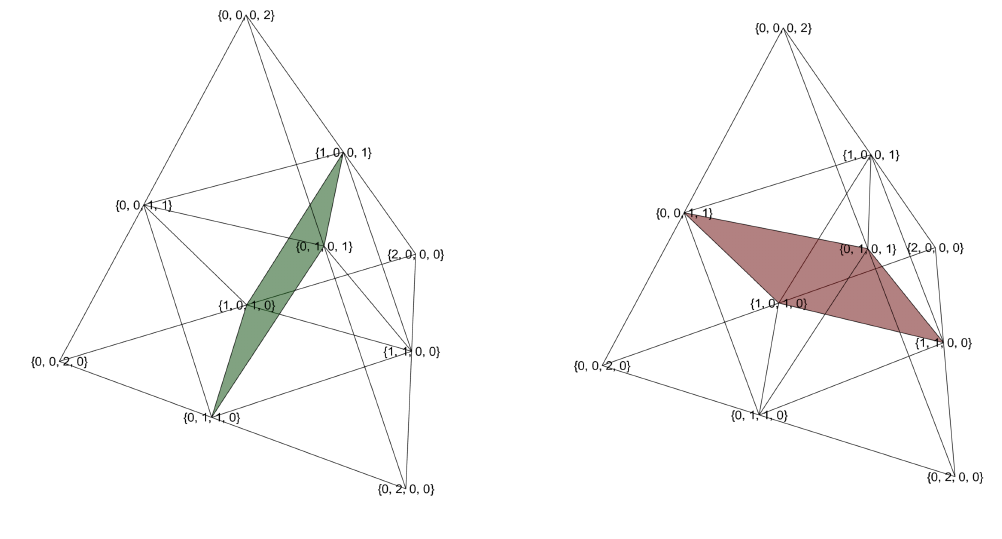
Figure 13 . Combinatorial construction of the s and t channels using matroid subdivisions: lift each hyperplane to a surface in R 4 which bends on exactly that hyperplane. Left: η 24 = s 12 . Right: η 13 = s 23